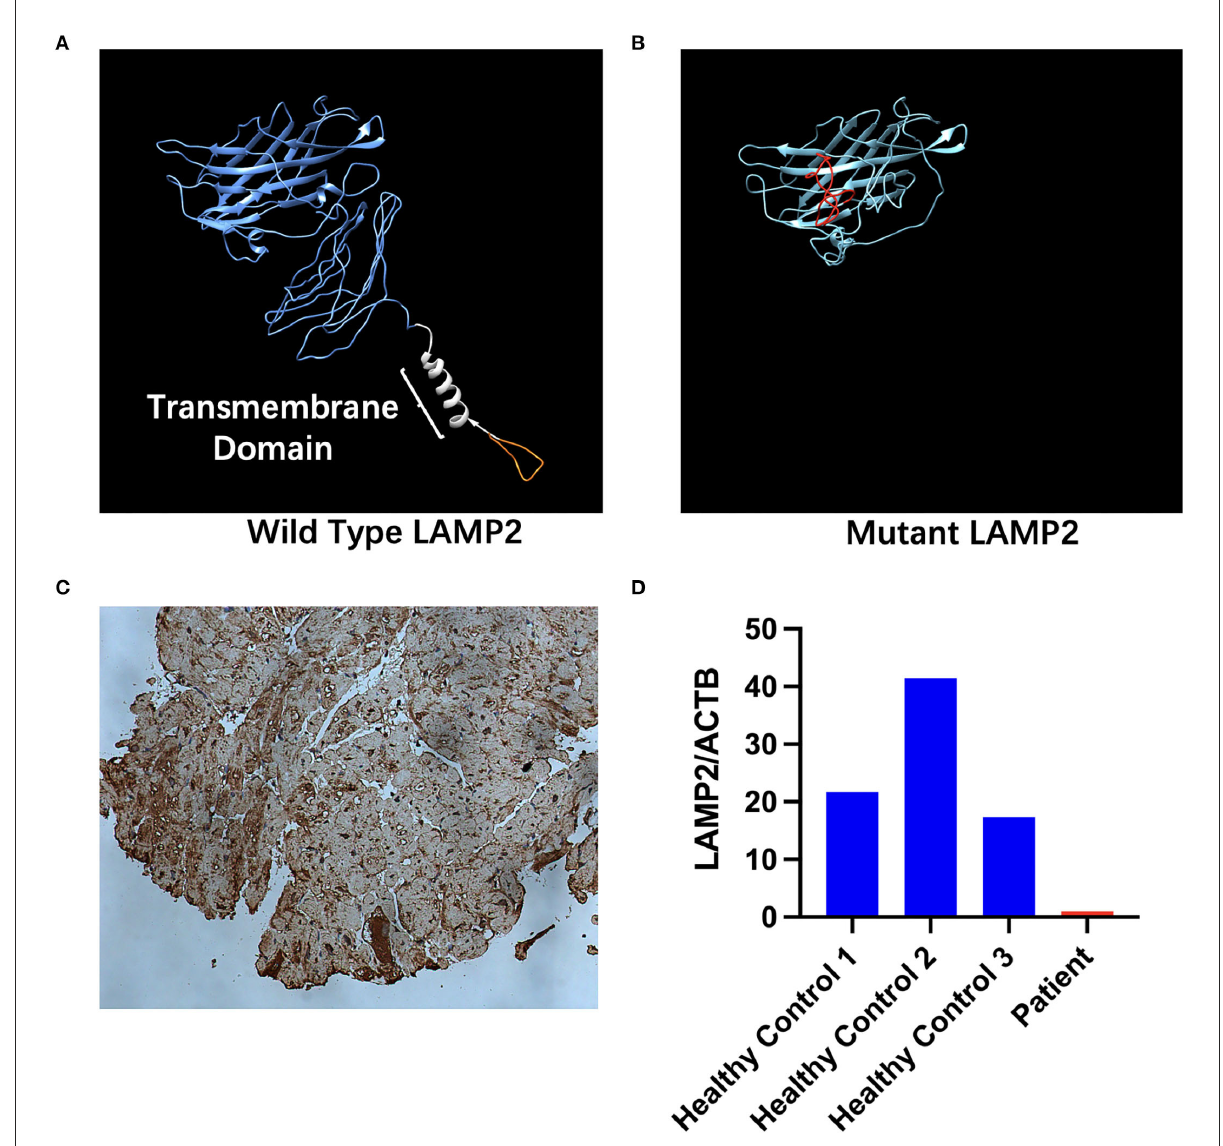
FIGURE4 Structure and expression changes caused by mutant LAMP2 . (A) in-silico structural modeling of wild-type LAMP2. The orange part shows the part that is truncated in the mutant LAMP2. The blue segment indicates the lumenal part of LAMP2. The white segment indicates the transmembrane part of LAMP2. The orange segment indicates the cytoplasmic part of LAMP2. (B) In-silico structural modeling of mutant LAMP2. The red segment indicates the mistranslated segment caused by the insertion mutation. The transmembrane helical domain is missing. (C) Immunohistochemical analyses for LAMP2. (D) Relative expression of LAMP2 in patient’s and healthy controls’ peripheral blood measured via proteomic